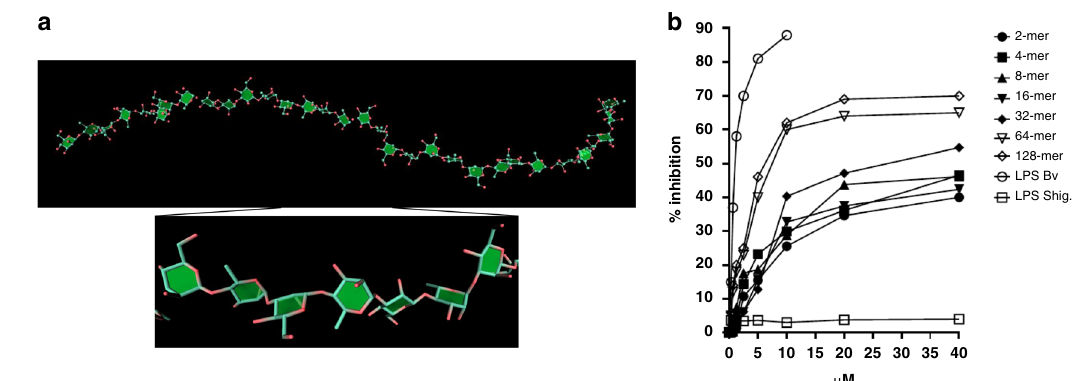
Fig. 4 Conformation and immunological activities. a A representative solution conformation of the 32-mer as determined by NMR and molecular simulation (Maestro Schrödinger), prepared with SweetUnitMol 39 ; b ELISA analysis of the competition binding of the glycans and LPS from B. vulgatus to the human C-type lectin DC-SIGN, with LPS from Shigella fl exneri as a negative control. The competition experiments have been performed three times showing similar results; the graph shows data of one of these experiments 40 . Source data are provided as a Source Data